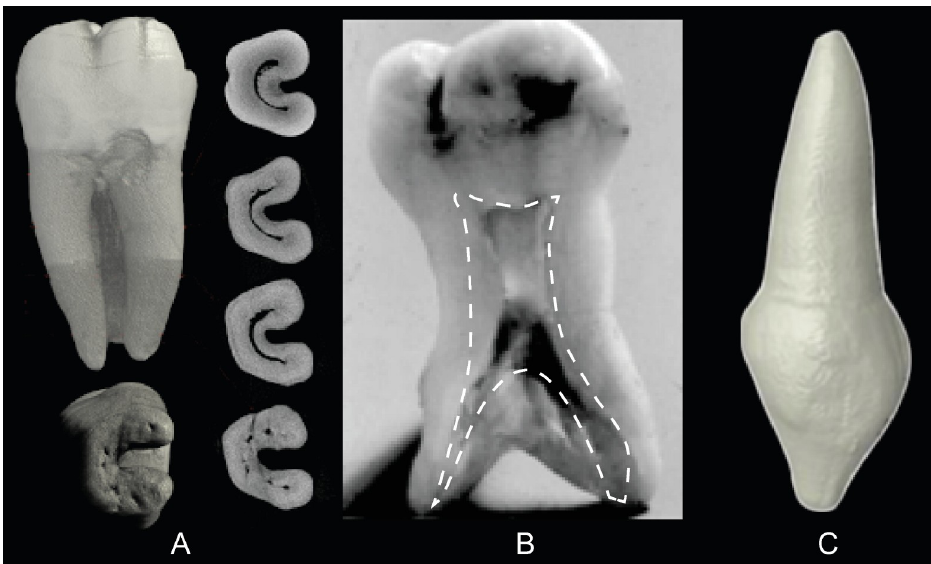
Fig 2. Unusual root forms. A. C-shaped tooth in (clockwise from top left) lingual, cross-section at the cemento- enamel junction, cervical third, middle third, apical third, and apical views. B. Taurodont molar, apically displaced pulp chamber and canals outlined in white. C. Peg-shaped root. Images A, C from the Root Canal Anatomy Project http://rootcanalanatomy.blogspot.com/ (accessed 10 March 2021). Image B from http://www.dentagama.com (accessed 27th March